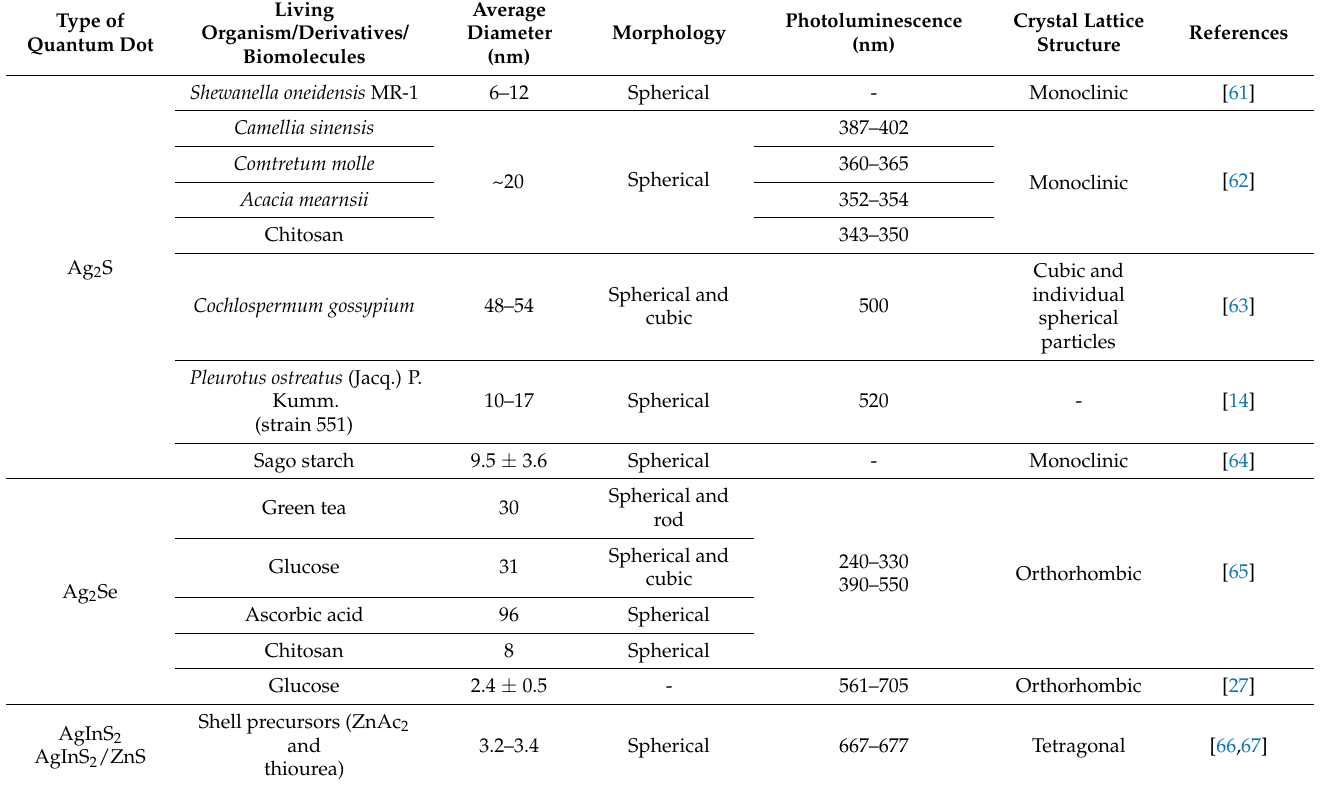
Table 3. «Green» synthesis, photoluminescence, and morphology of Ag-based quantum